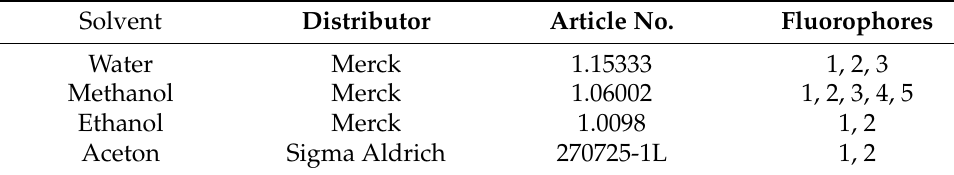
Table 9. Solvent used for the different types of